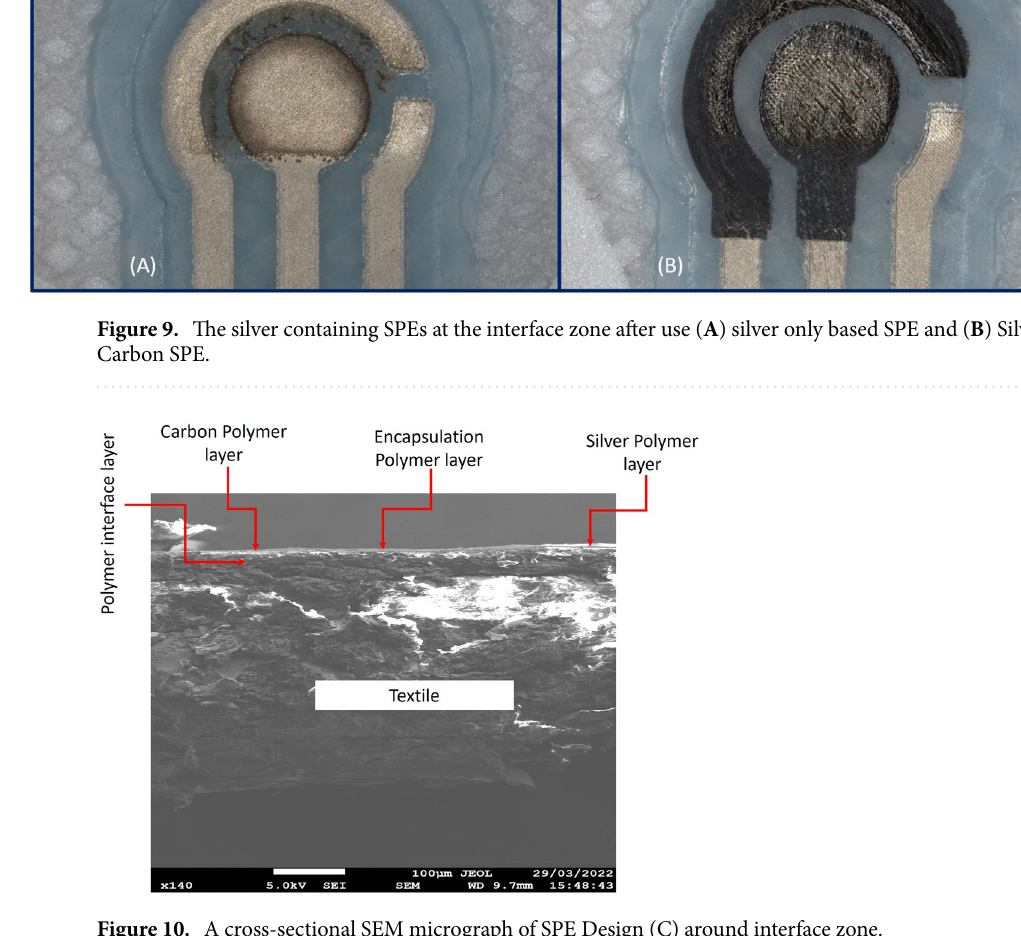
Figure 10. A cross-sectional SEM micrograph of SPE Design (C) around interface zone.